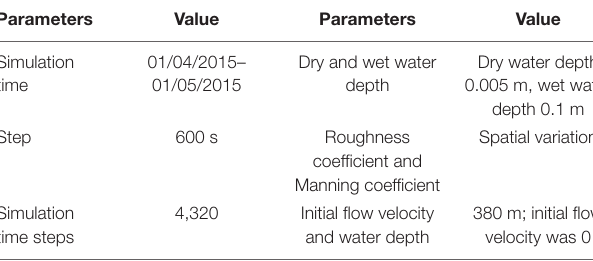
TABLE 2 | Parameters setting of MIKE 21 model.